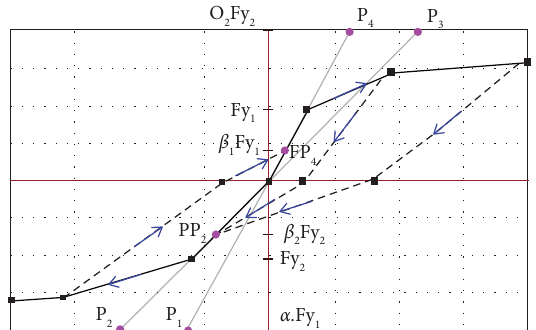
Figure 9: Pivot hysteretic model (Dowell et al. [47]) for the SDOF system. Table 4: Distribution of reinforcements in walls.